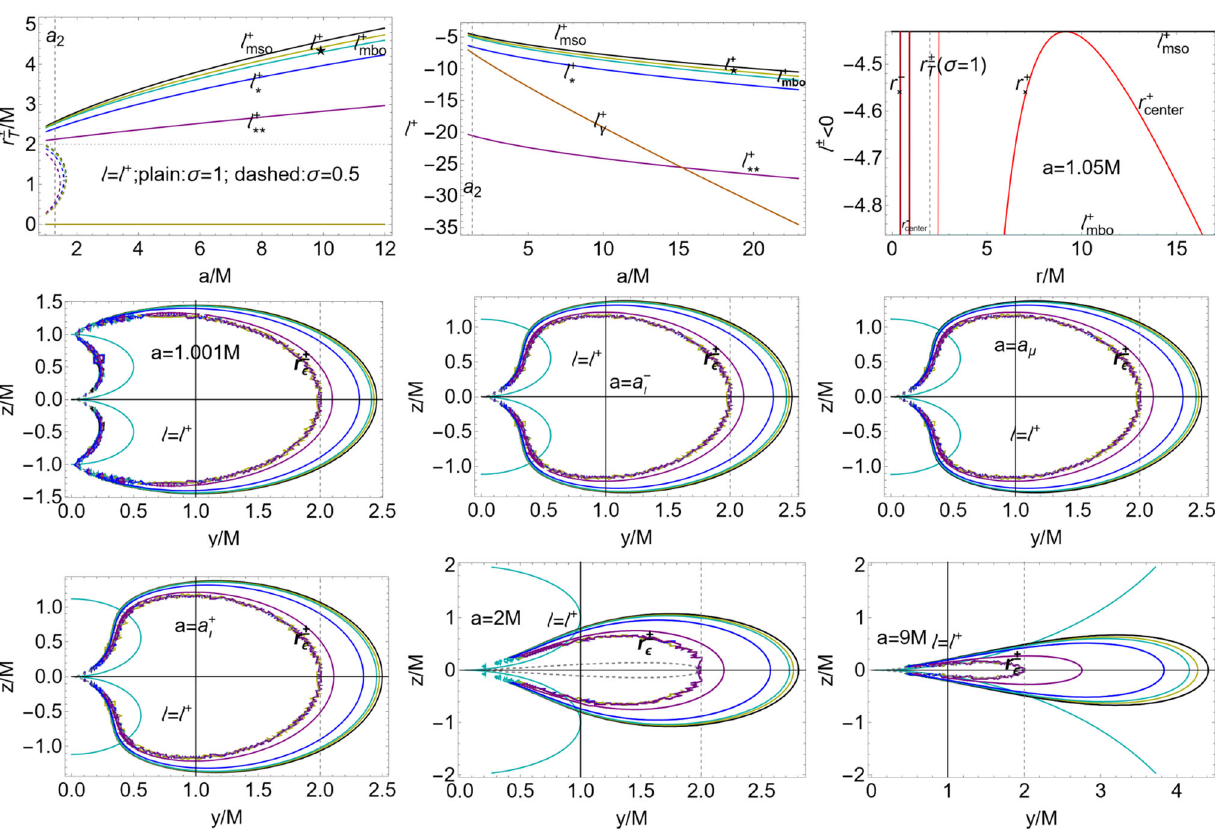
Fig. 13 Tori with fluids specific angular momentum (cid:6) + < 0 and bounded orbit). Upper center panel: specific angular momenta as func- (cid:6) − = (cid:6) + < 0 and flows inversion points. (The most general solu- tions of a / M . Upper right panel: specific angular momentum (cid:6) ± < 0 tions r ± (cid:2) are shown, discussion on the constraints are in Sect. 3.2.) as function of r / M for the NS spin a = 1 . 05 M . Remaining pan- els show the inversion radius r ± (cid:2) on the plane ( y / M , z / M ) , where Spins a ± ι are defined in Eq. (11). Radius r cr = r + (cid:2) = r − (cid:2) is defined in (cid:6) σ = sin 2 θ = y 2 /( z 2 + y 2 ) and r = Eq. (10). There is a μ ≡ a + ι − ( a + ι − a − ι )/ 2, and the fluid specific angu- z 2 + y 2 , for different fluid ∓ 1 . 5, (cid:6) ± ≡ (cid:6) + ∓ 15 . 5. There lar momenta ((cid:6) + ∗ ,(cid:6) + ∗∗ ) are (cid:6) ± ∗ ≡ (cid:6) + specific angular momenta (cid:6) , according to the notation signed on the ∗∗ mbo mbo )/ 1 . 25. Radii r ± upper line left panel. Tori models and accretion flows inversion points is (cid:6) + (cid:22) ≡ (cid:6) + ( r + (cid:22) ) , where r + (cid:22) ≡ ¯ r + mso − ( ¯ r + mso − r + (cid:11) are mbo are shown in Fig. 10 and 19. Note the inversion radius location with the outer and inner ergosurfaces. Upper left panel: inversion radius r ± (cid:2) respect to the ergosurfaces r ± (cid:11) . Figure20 show the analysis for fluids on different planes σ ≡ sin 2 θ and specific angular momenta signed on with momenta (cid:6) = (cid:6) − the panel. (mso is for marginally stable orbit and mbo is for marginally